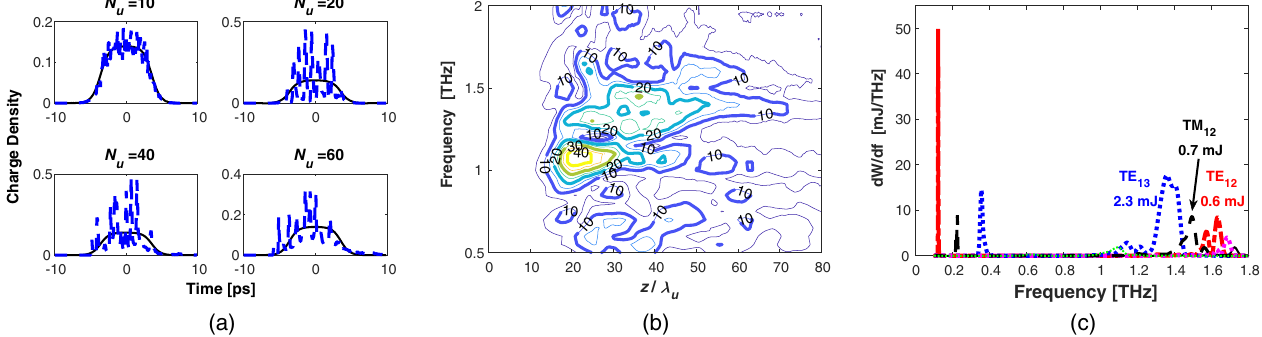
FIG. 11. Nonmodulated bunch with a charge of 5 nC, a duration of 10.6 ps, and smoothed edges in NMI regime (over-resonance guiding field of 75 kG): (a) charge density after 10 to 60 undulator periods, (b) contours of the bunching factor, and (c) radiation spectrum after 60 undulator periods.